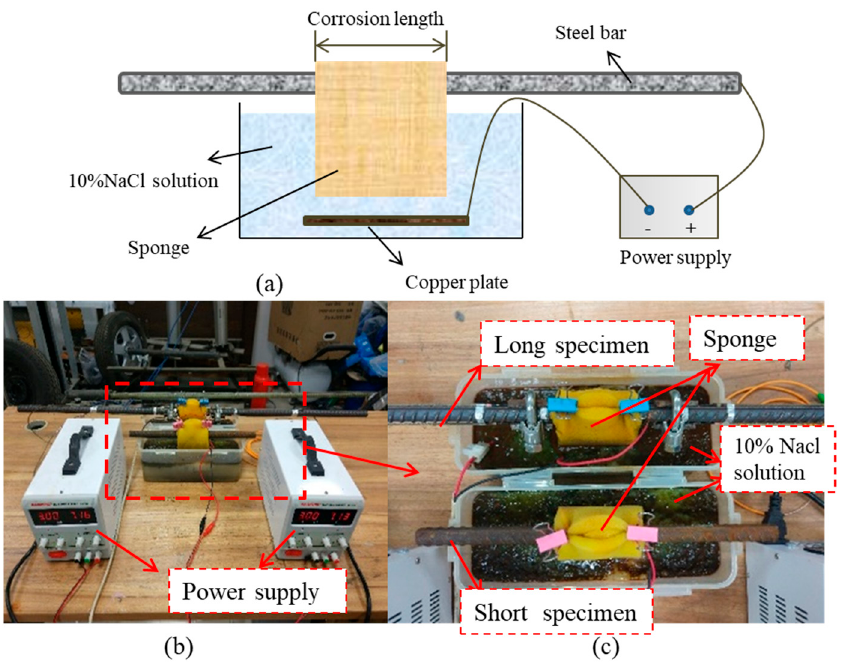
Figure 8. Corrosion calibration test. ( a ) Illustration of the accelerated corrosion; ( b ) Calibration test; ( c ) Details of two